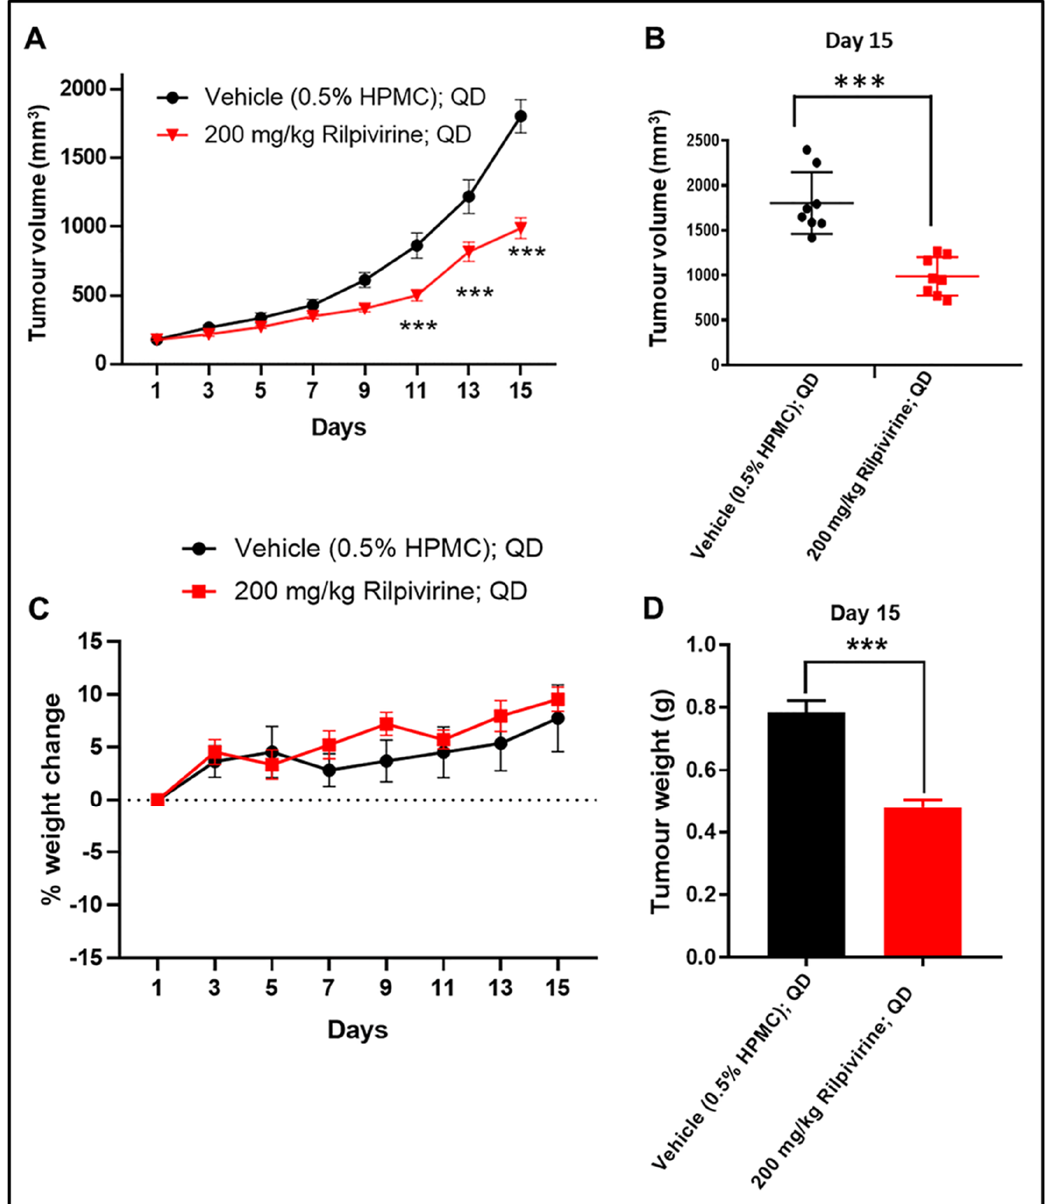
Figure 6. In vivo anti-leukaemic efficacy of rilpivirine in the HL-60 xenograft model. Animals ( n = 8 per group) with subcutaneously implanted HL-60 leukaemia xenograft were treated with vehicle (0.5% HPMC in water, QD) or rilpivirine (200 mg/kg, QD) orally for 15 consecutive days. ( A ) Graph showing tumour volumes at different measurement days (*** p < 0.001; determined by one-way ANOVA). ( B ) Dot plot showing individual tumour volume on day 15 (horizontal line indicates the means, while vertical lines indicate standard deviations). *** p < 0.001; determined by unpaired Student’s t -test. ( C ) Body weight changes in different groups. Data presented as mean ± SEM. ( D ) Graph showing mean tumour weights of the vehicle and rilpivirine-treated groups on day 15. (*** p < 0.001; determined by unpaired Student’s t -test).